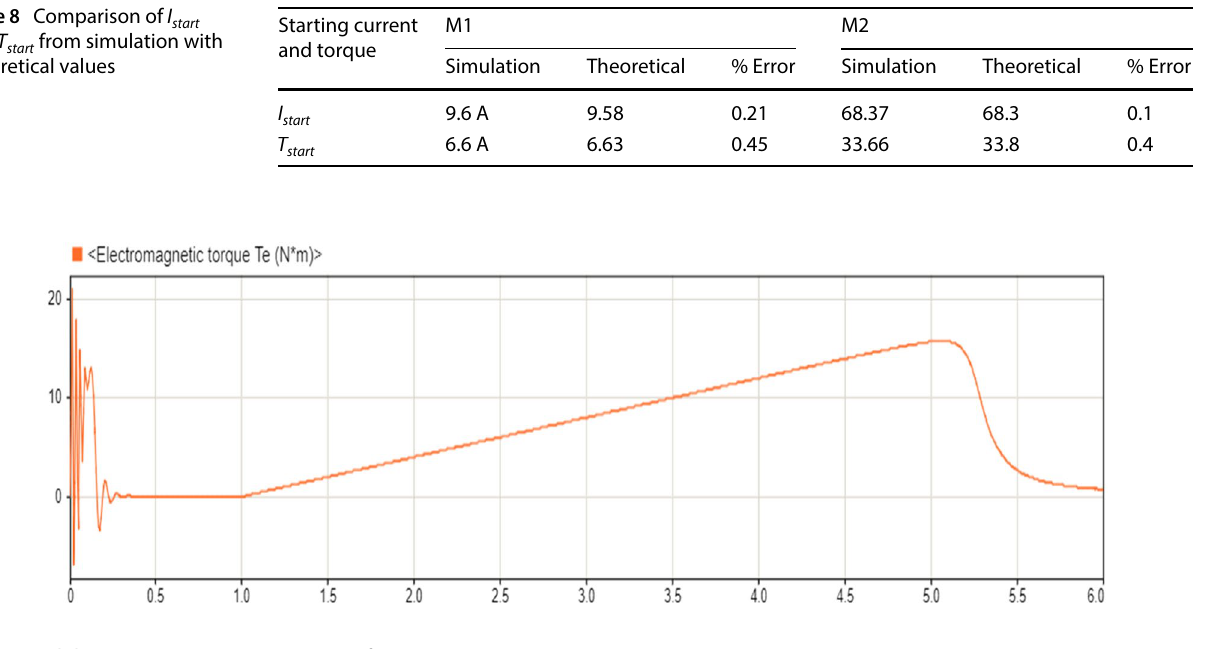
Fig. 6 Breakdown torque (Nm) versus time (s) for motor M1 Table 9 Comparison of s max and T start from simulation with theoretical